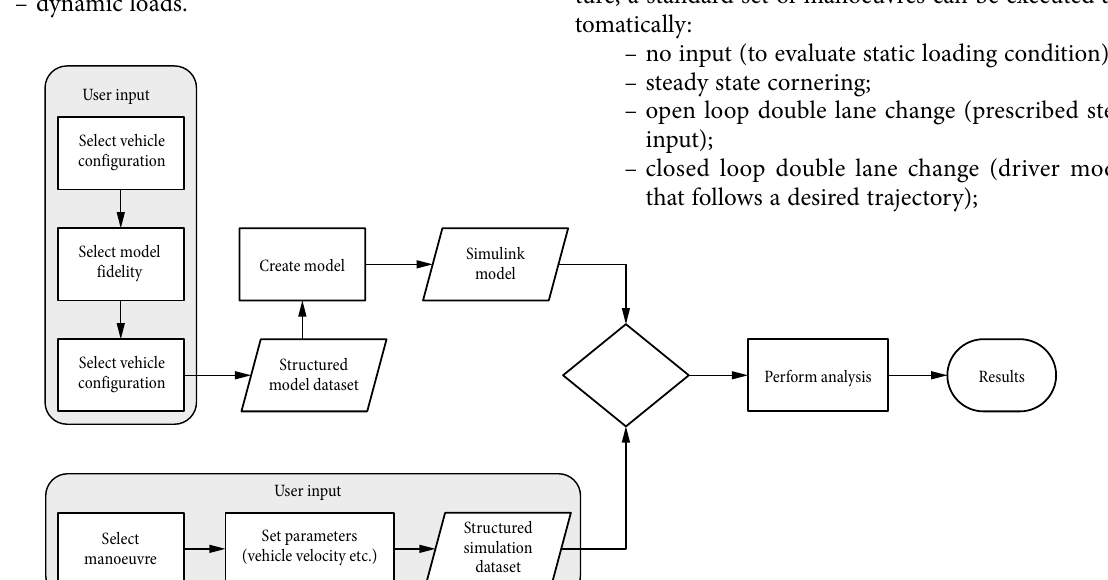
Fig. 7. Automatic model